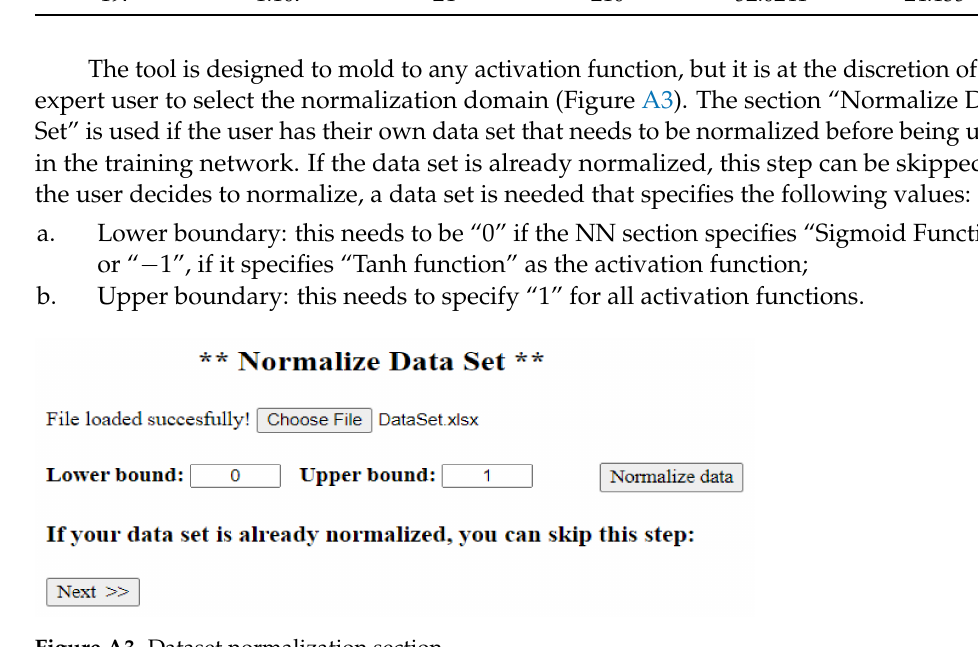
Figure A3. Dataset normalization